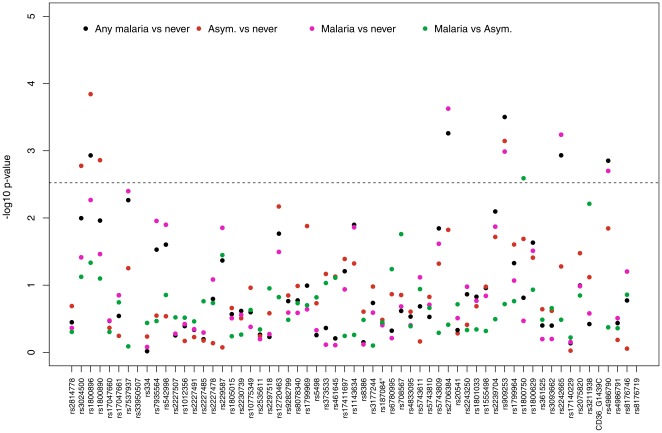
Minimum p-values from tests of association for the autosomal SNPs.*any malaria: Any_malaria group (clinical malaria, asymptomatic infection and previous history of malaria); asym: Asymptomatic group (individuals with asymptomatic infection); malaria: Clinical_Malaria group (current or previous history of mild malaria); never: never_malaria group (no history of previous malaria); genotypic tests of dominant, recessive, general, heterozygous advantage, and additive models, adjusted for gender; the dashed line represents a p-value of 0.003.